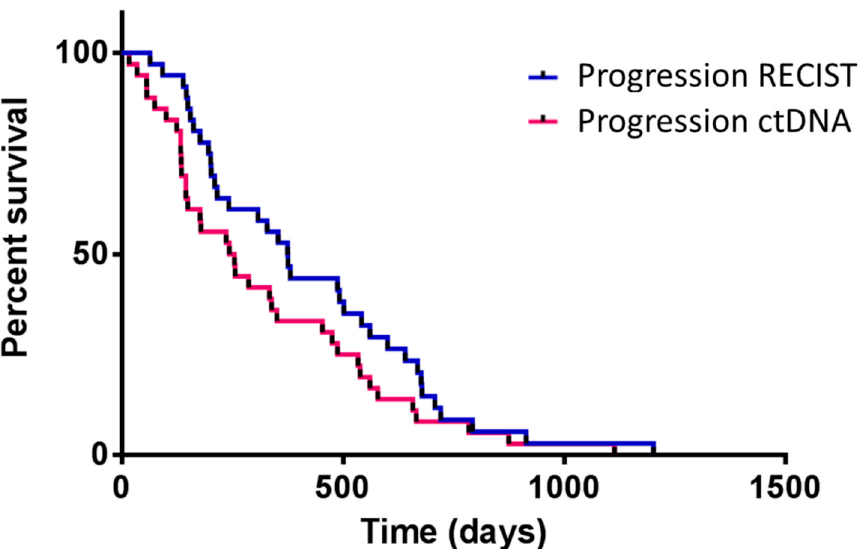
Figure 2. Detection of disease progression according to RECIST or by reappearance of ctDNA. X-axis represents the time (days) from 1 July 2018 (start of liquid biopsy sample collection) or the day of first diagnosis (if after 1 July 2018). Median progression “survival” was 375 days on RECIST and 249 days on ctDNA. Based on the Gehan–Breslow–Wilcoxon test, the two curves are significantly different ( p = 0.04).